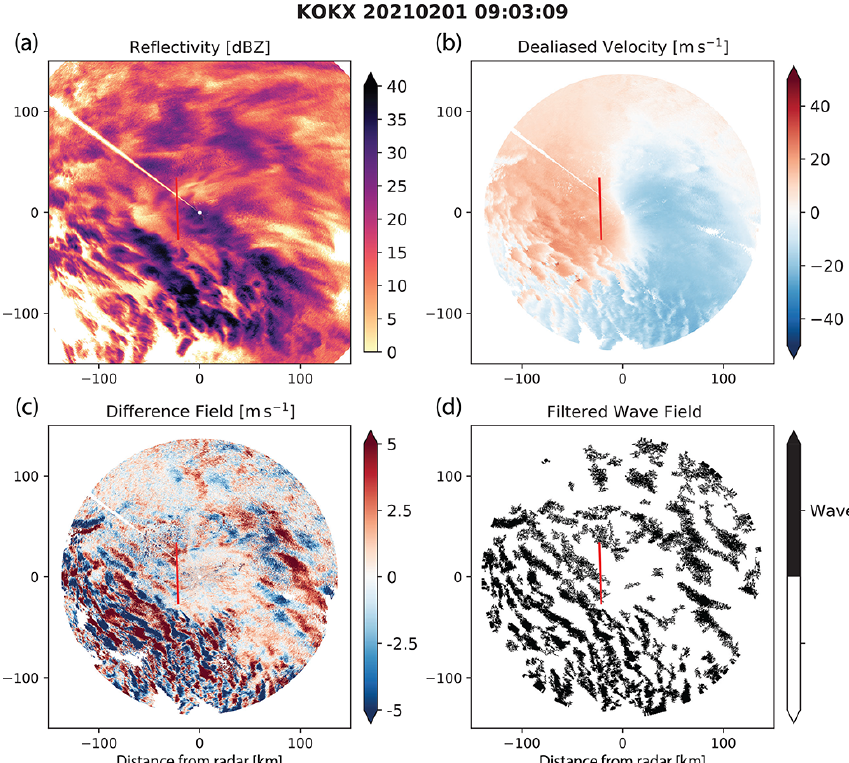
Figure 5. (a) Reflectivity and (b) dealiased radial velocity for the NWS KOKX precipitation radar in Upton, NY, on 1 February 2021 at 09:03UTC. (c) The difference between (b) and the prior dealiased radial velocity field at 08:56UTC (not shown) and (d) the resulting binary wave detection field. The red line in each panel denotes the RHI scan from the KASPR radar location at Stony Brook University shown in Fig. 6. An animated version of this figure is in Video Supplement